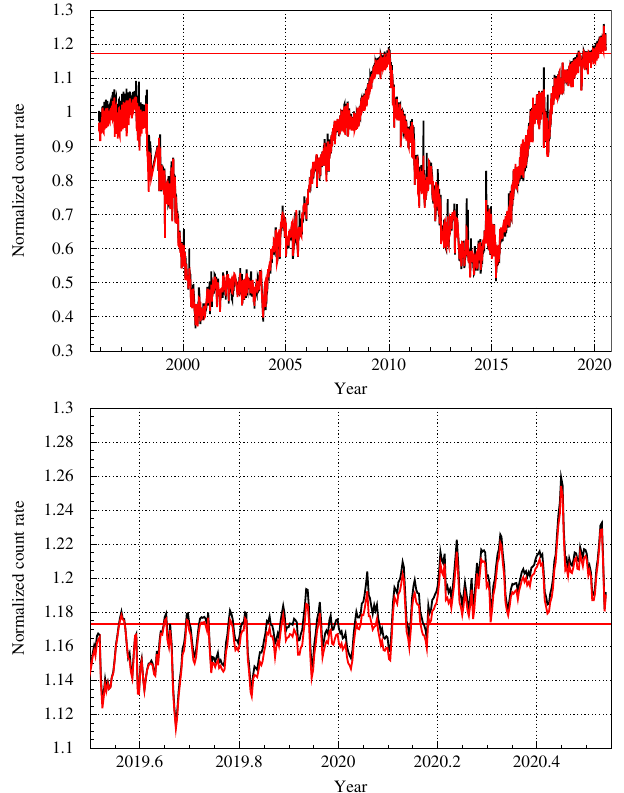
Fig. 4. Uper and lower panel display the daily averaged quiet time galactic cosmic ray fl ux variation over the last two solar cycles and from July 2019 to July 2020, respectively. The black and red line show the count rate variation of the anti coincidence detector G and the SSD F using counting rate thresholds in SSD B omitting time periods of increased energetic particle fl uxes (for details see text).